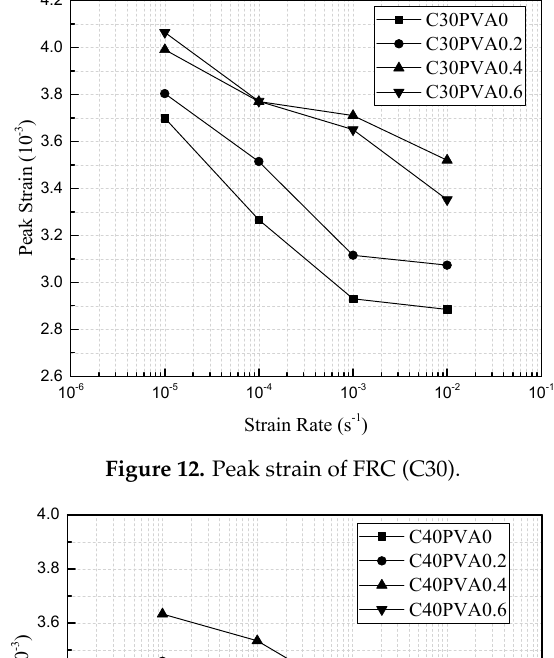
Figure 12. Peak strain of FRC (C30).